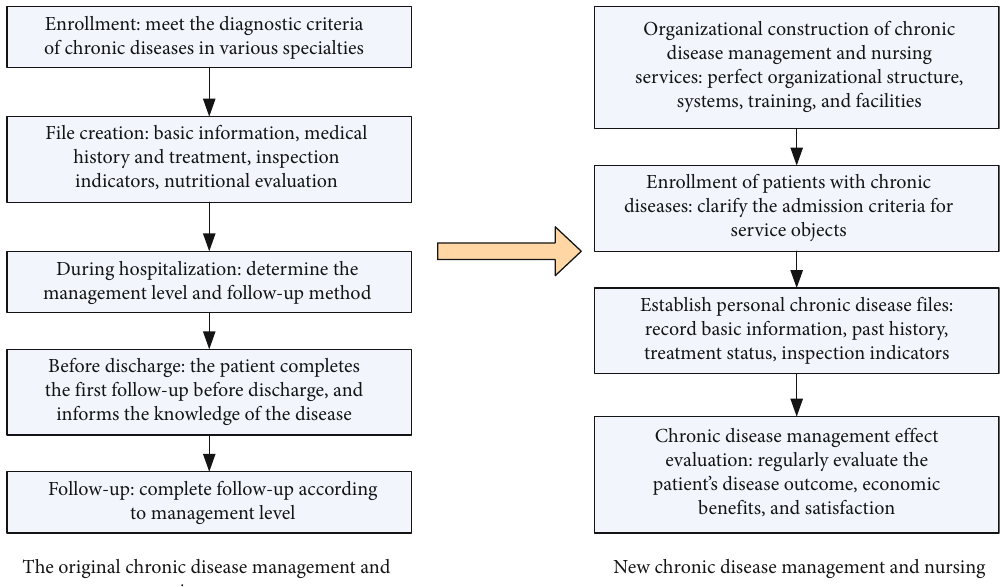
Figure 4: Comparison of the original chronic disease care management process and the new chronic disease care management